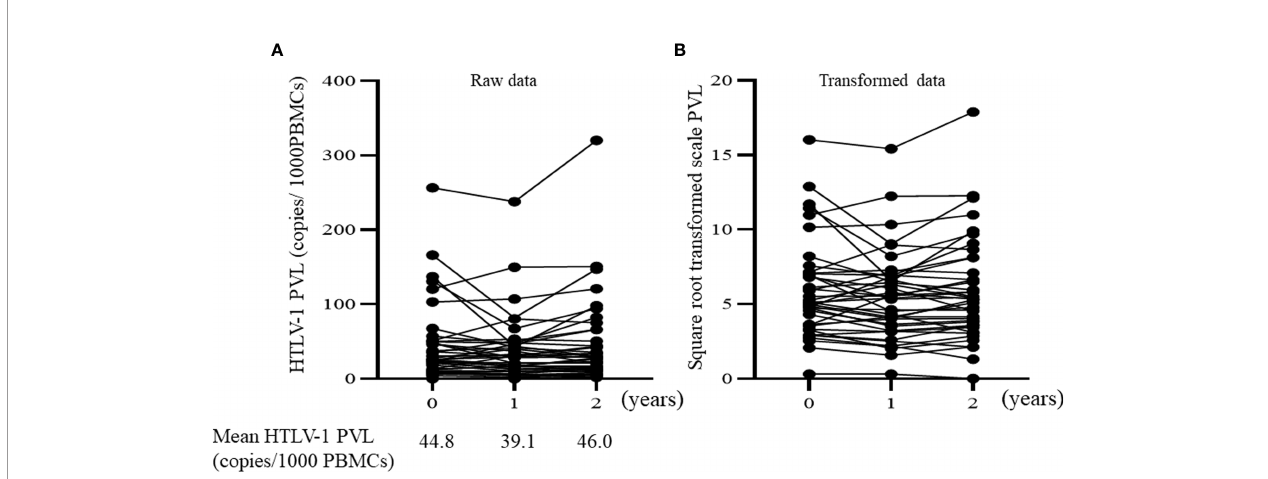
FIGURE 2 | Time course of HTLV-1 PVL over 2 years. (A) Raw data of proviral load. The mean HTLV-1 PVL are expressed under the graph. (B) Square-root transformed values of the raw proviral load. HTLV-1 PVL , Human T-cell leukemia virus type 1 proviral load; PBMCs , peripheral blood mononuclear